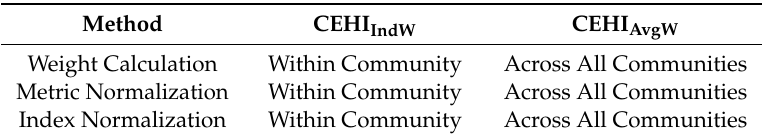
Table 2. Summary of how weight calculation, metric normalization, and index normalization were done for CEHI IndW and CEHI AvgW